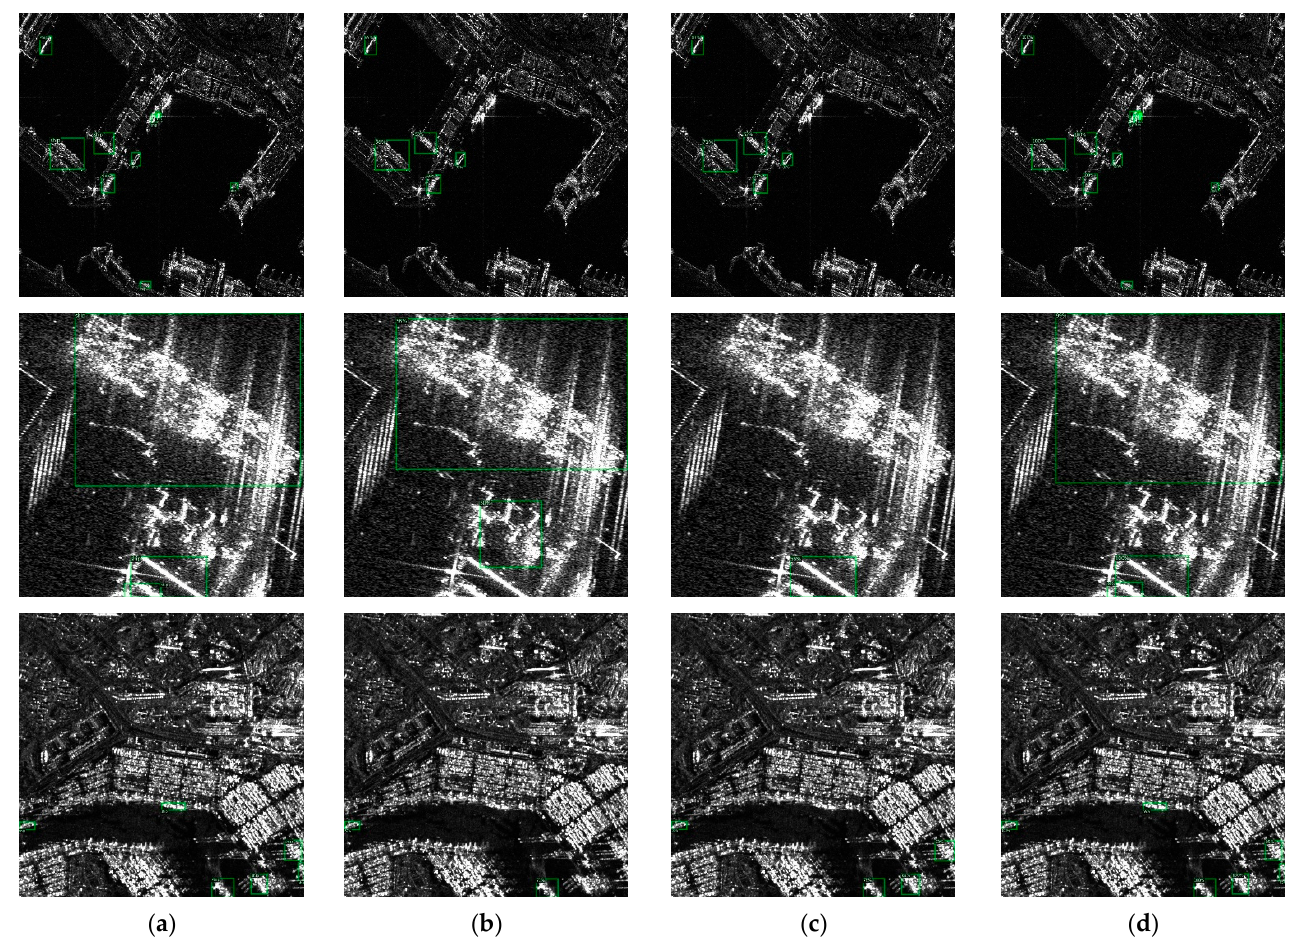
Figure 11 . Comparison of the results of different methods. ( a ) Ground truths. ( b ) Detection results of HR-SDNet. ( c ) Detection results of ResNet-50+Quad-FPN. ( d ) Detection results of SCSA-Net.